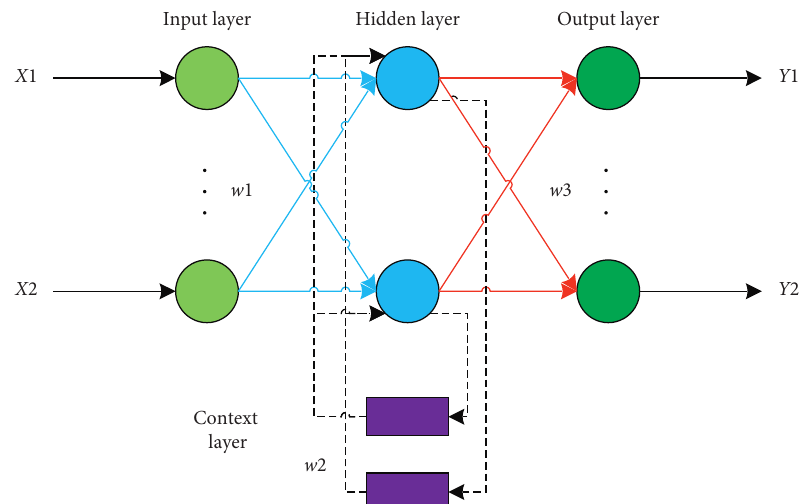
Figure 2: Topology structure of Elman neural